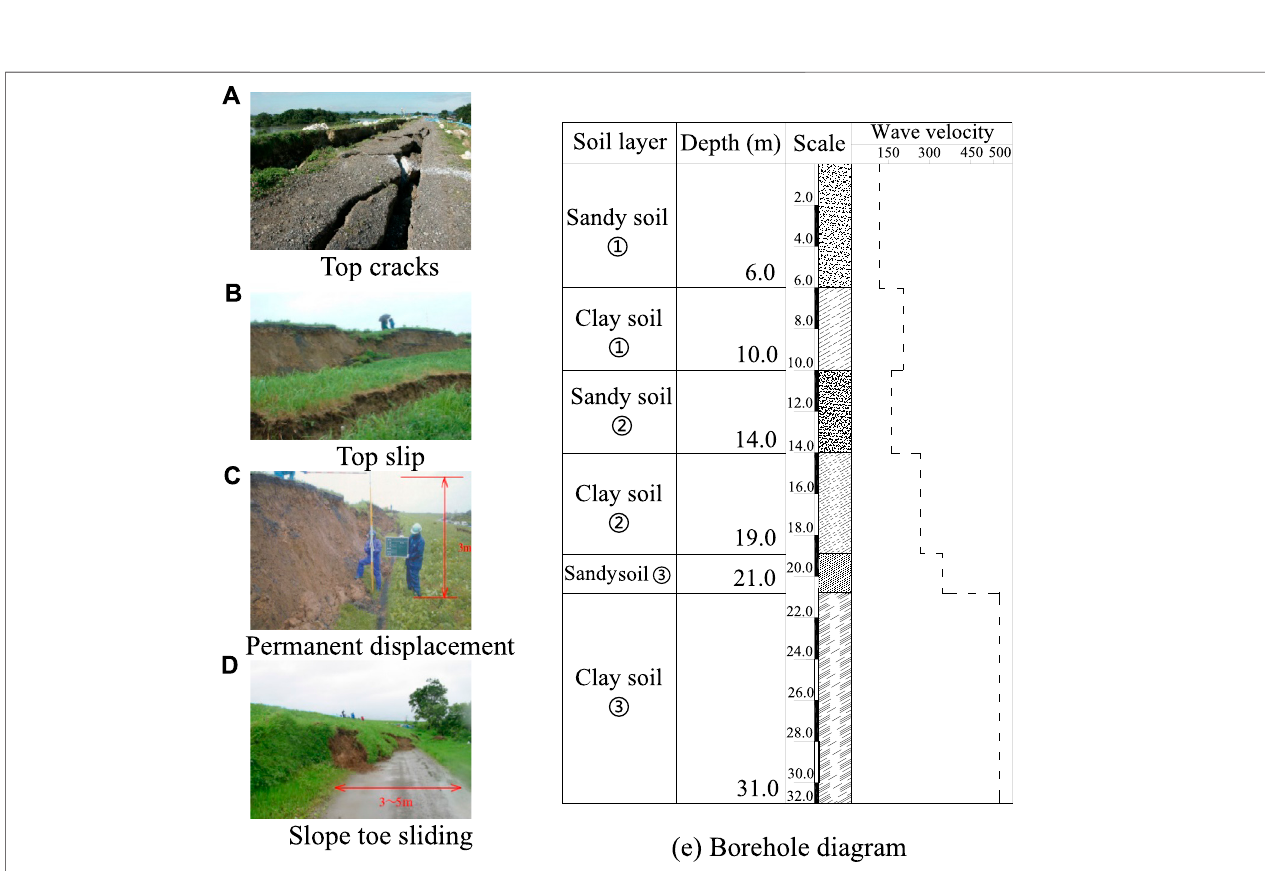
FIGURE 5 | Sliding and other formation information of the bank slope after the earthquake. (A) Top cracks. (E) Borehole diagram. (B) Top slip. (C) Permanent displacement. (D) Slope toe sliding.